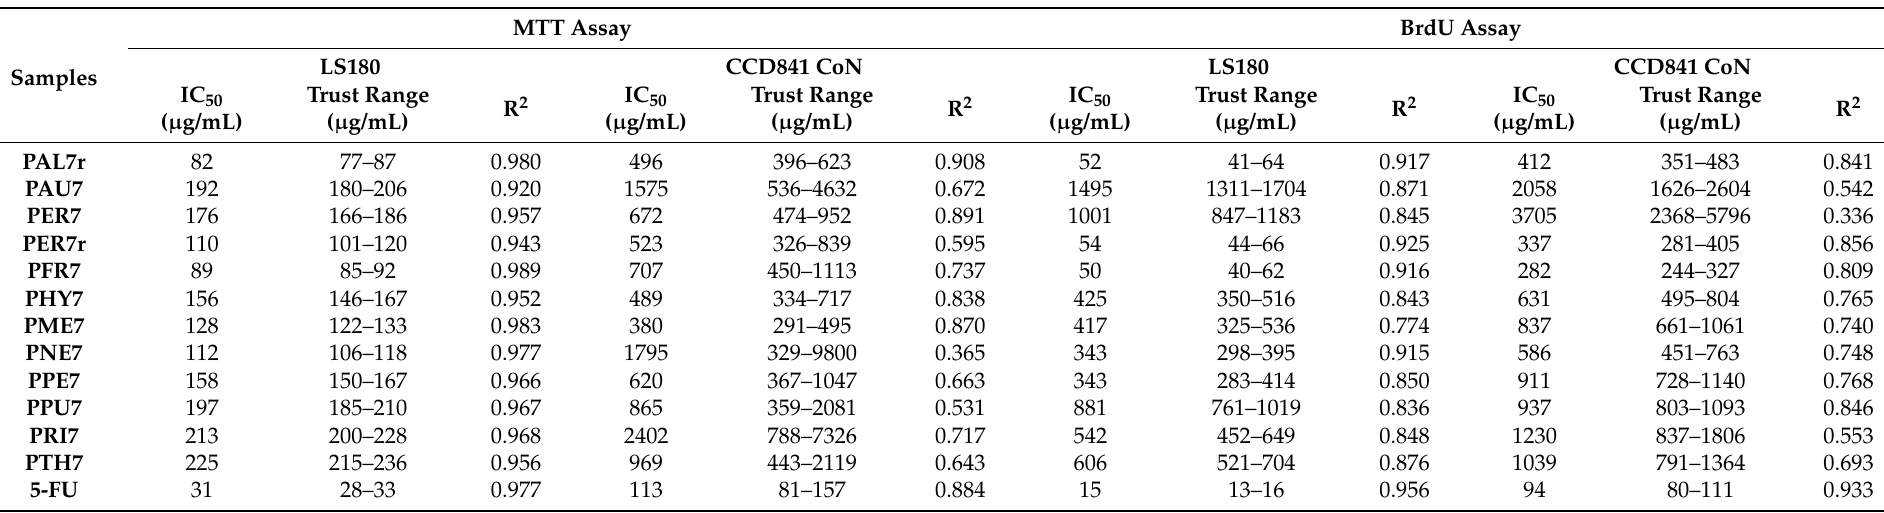
Table 3. IC 50 values (concentration causing viability/proliferation inhibition by 50% compared to control) of aqueous acetone extracts isolated from selected of MTT as well as BrdU assays performed after 48 h of cells’ treatment with investigated